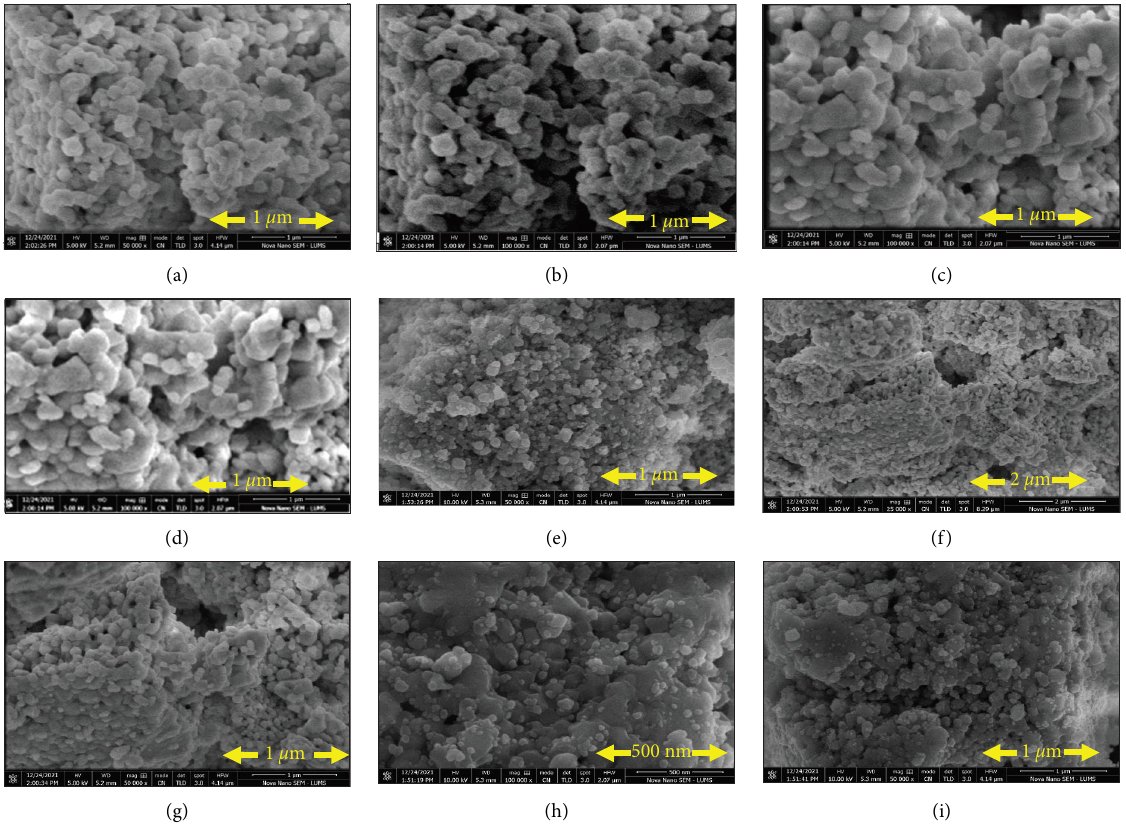
Figure 7: SEM images of fresh catalysts: (a) C-0, (b) C-2, (c) C-4, (d) C-6, (e) C-8, (f)–(h) C-10, and (i) C-15.